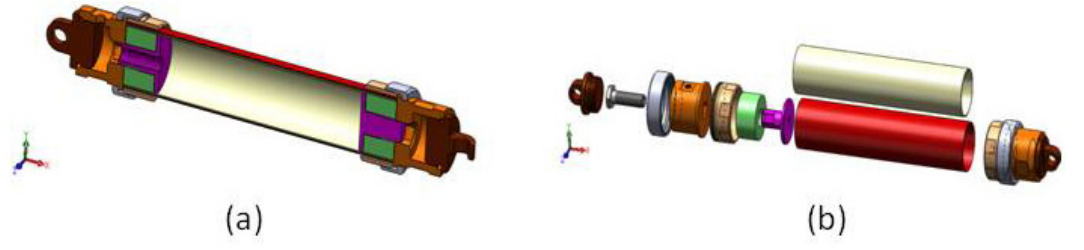
Figure 3. Structure of the DIMEAS pneumatic muscle: ( a ) geometrical model; ( b ) exploded